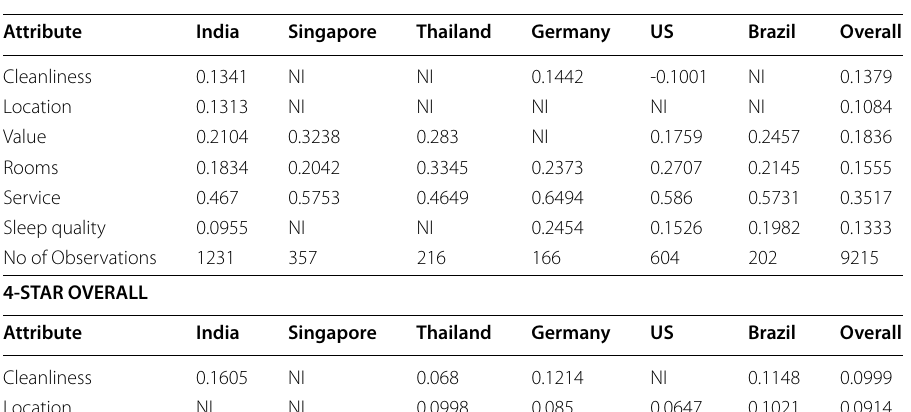
Table 7 Final overall results for each hotel class upon country wise 5‑STAR